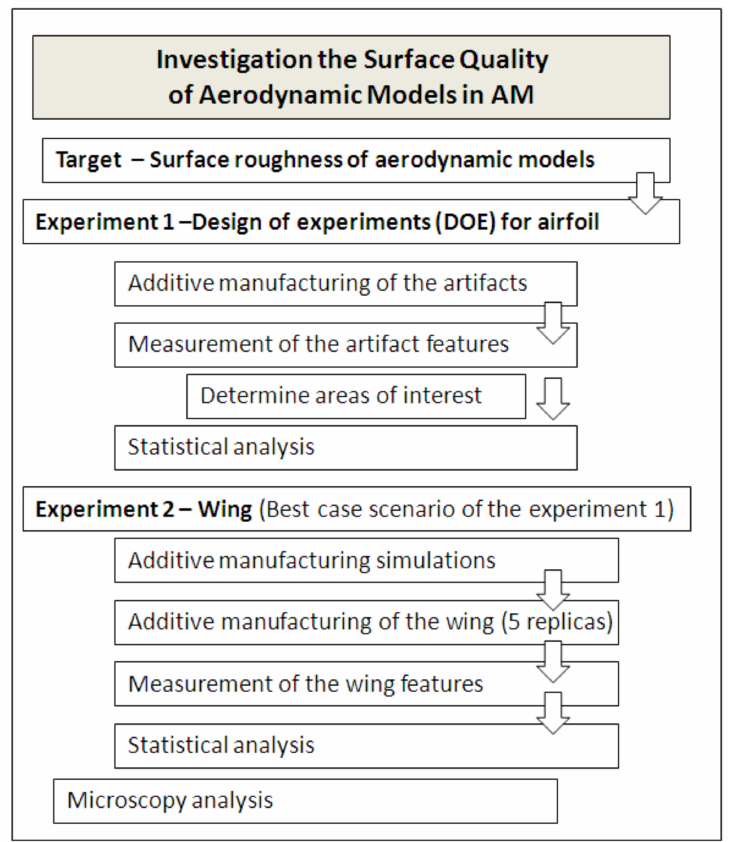
Figure 1. Flowchart of the proposed methodology of investigation of the surface quality of aerody- namic models produced by additive